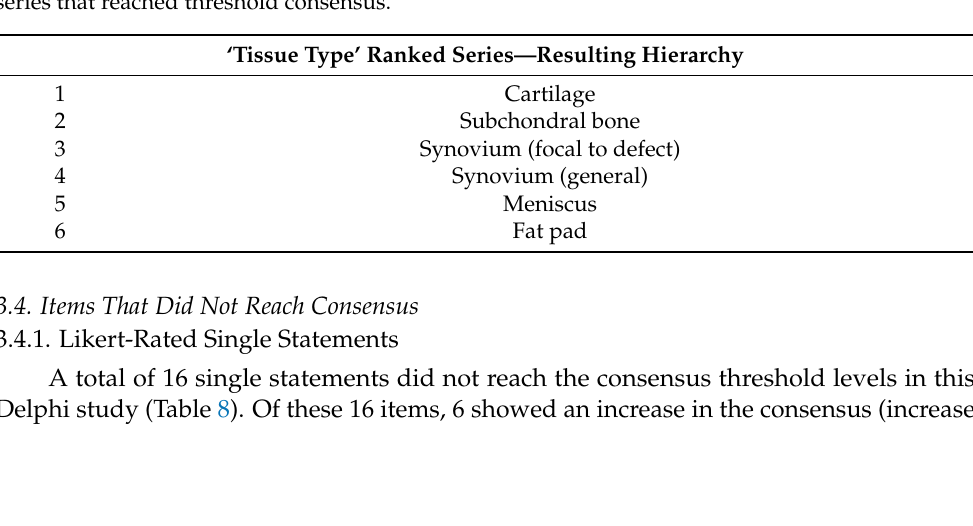
Table 7. The resulting ‘Tissue Type’ hierarchy based on the mean ranks of the items in the ranked series that reached threshold